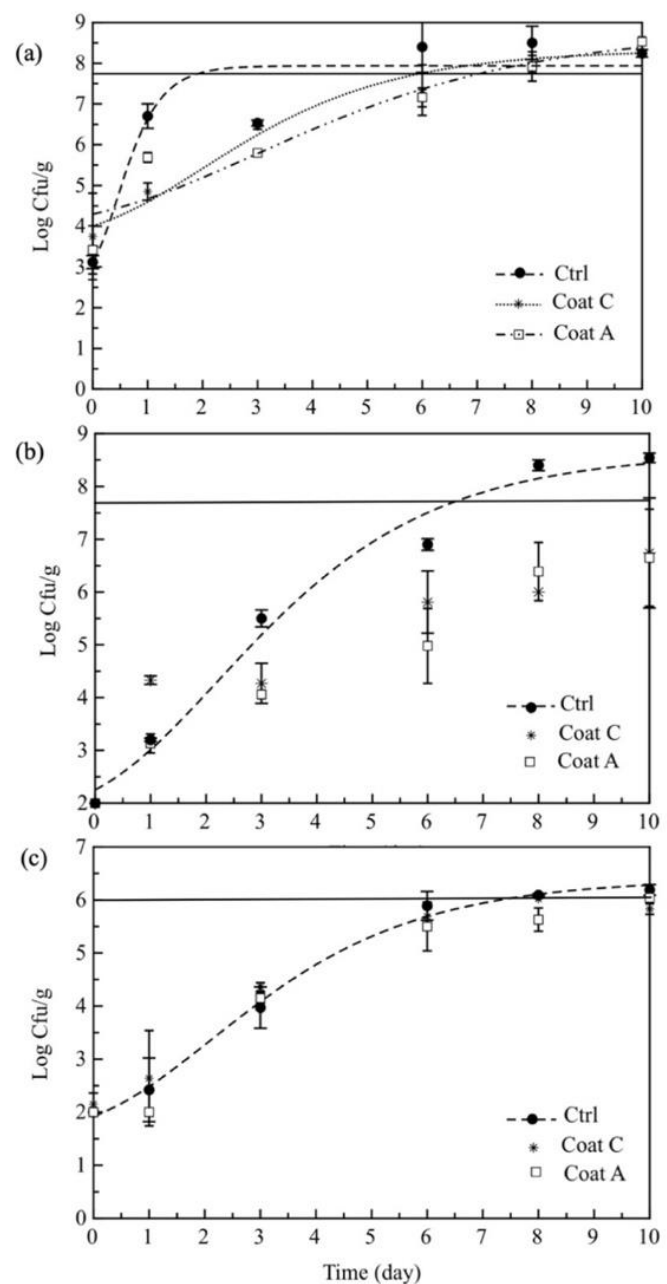
Figure 3. Mesophilic ( a ), psychrotrophic bacteria ( b ) and yeasts ( c ) in control and coated prickly pears stored at 4 °C. Data are presented as mean ± standard deviation. Curves are the fitting to the experimental data. The line indicates the threshold. Data not reaching the threshold were not fitted. Ctrl = sample without coating; Coat C = sample with alginate coating; Coat A = sample with alginate and peels.